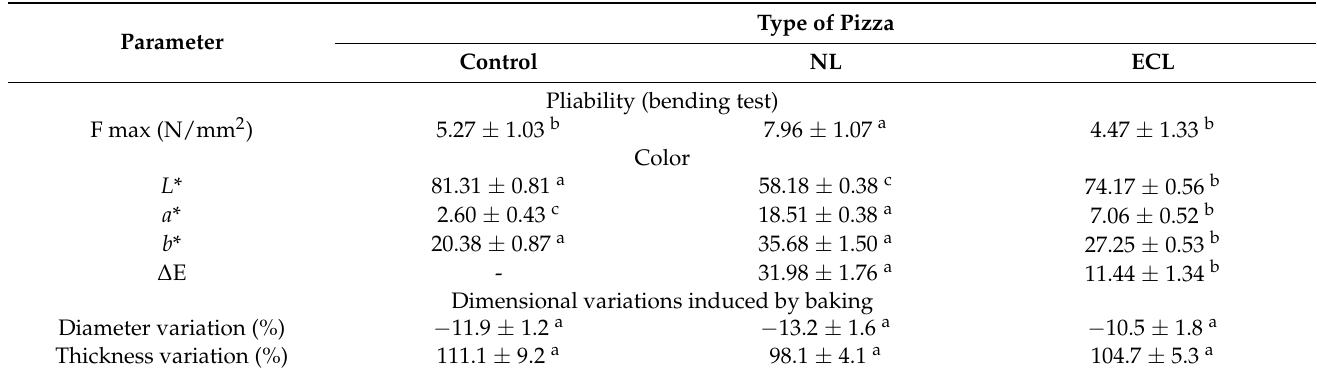
Table 7. Pliability, color, and dimensional variations of the experimental GF pizza samples. NL = native lentil flour; ECL = extruded-cooked lentil flour.